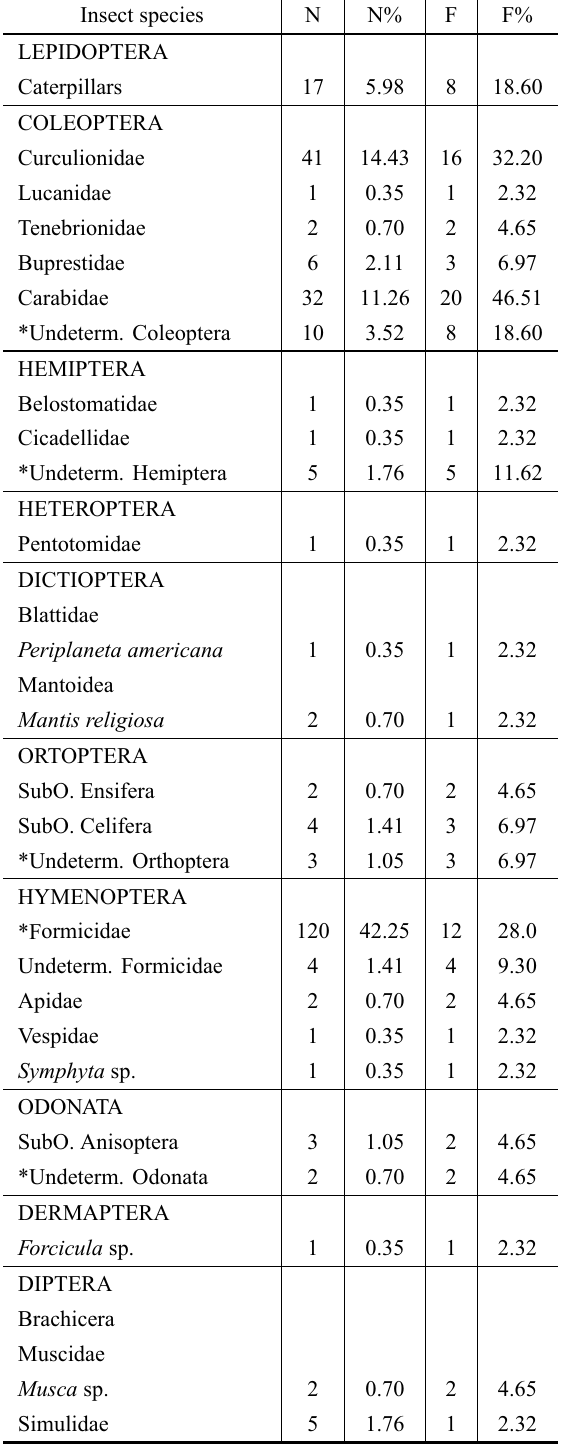
Insect species by number (N) and frequency (F) of occurrence consumed by Embernagra platensis during the summer at the Laguna de